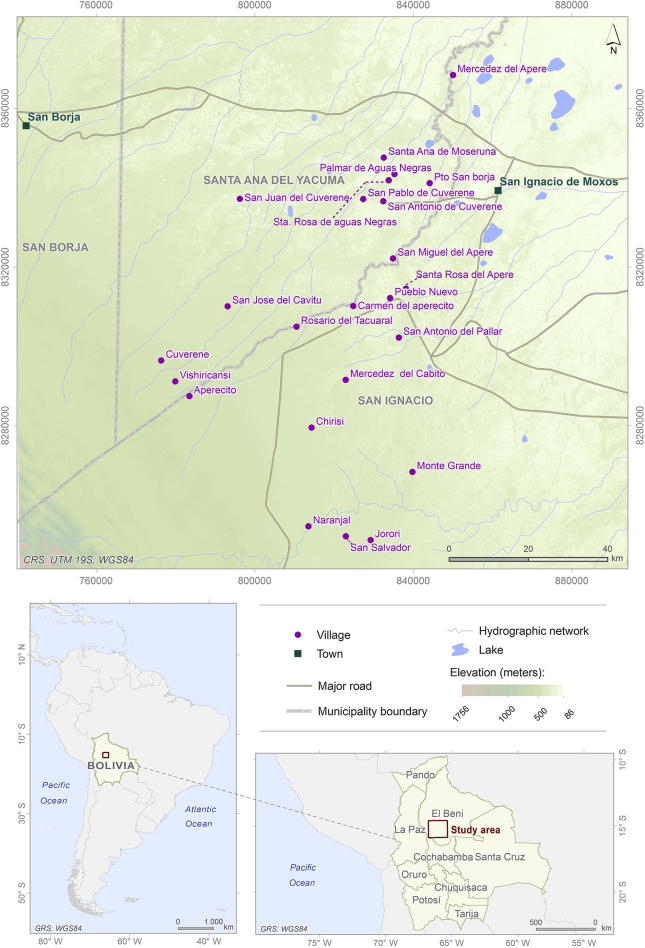
Map of the study area (Territorio Indígena Multiétnico, Dept. of Beni, Bolivia). Source: elaborated with cartographic data from Digital Chart of the World, GDAM and GeoBolivia (ASTER GDEM) repositories. Digital Chart of the World: http://worldmap.harvard.edu/data/geonode:Digital_Chart_of_the_World. GDAM: http://www.gadm.org/. GeoBolivia: http://geo.gob.bo/#map.